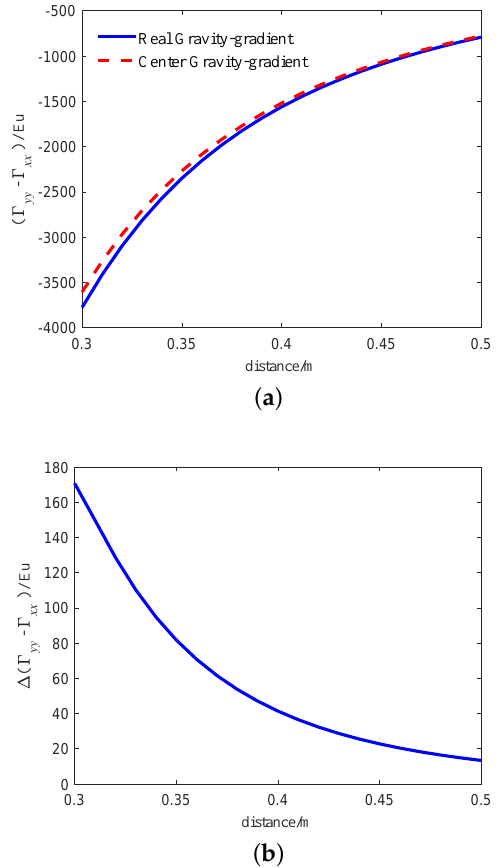
Figure 8. Gravity-gradient of the two models based on the sphere. ( a ) The relationship between the calculated results of the two models and the distance. ( b ) The relationship between the calculated results error of the two models and the